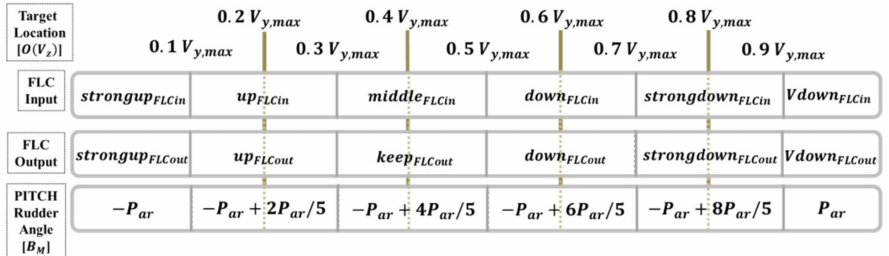
Figure 9. Relationship between the target’s image vertical coordinate axis and the FLC pitch